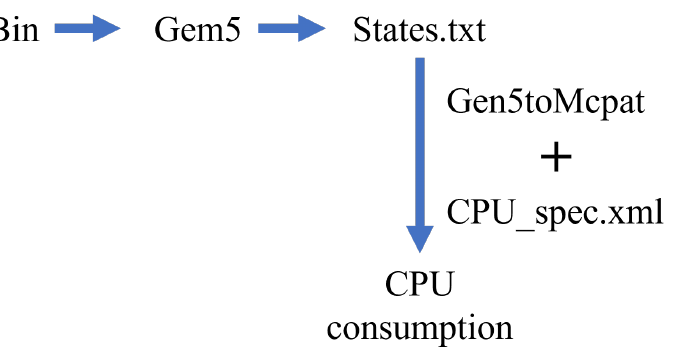
Figure 13. Simulation of an A9 processor running with LeNet-5.